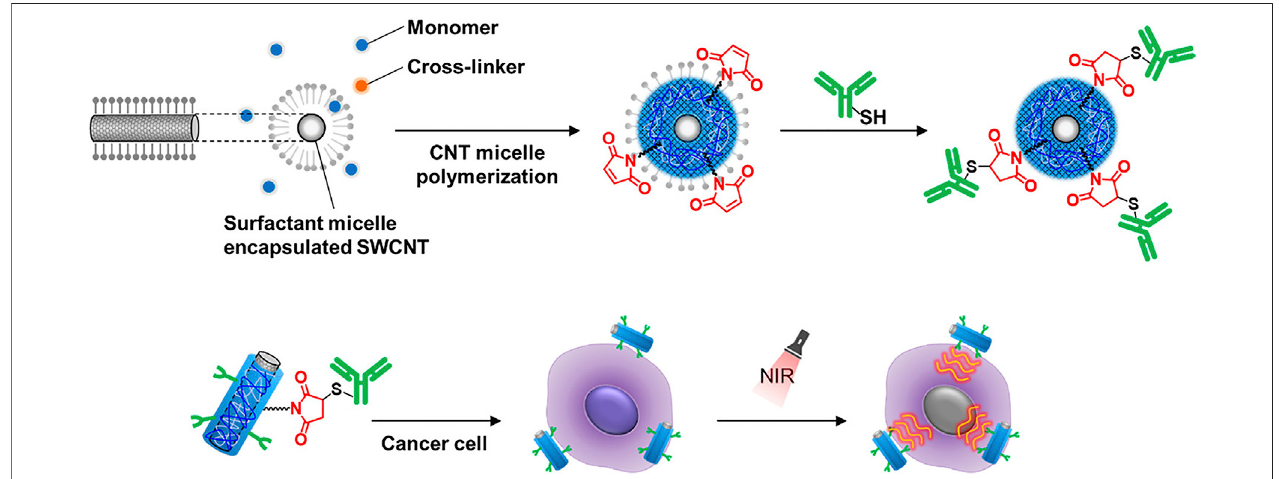
FIGURE 4 | Illustration of the process used for the modi fi cation of single-walled carbon nanotubes (SWCNTs) with antibodies using the ene-thiol reaction and the use of the modi fi ed SWCNTs in the PTT-mediated killing of cancer cells (Nagai et al., 2021).